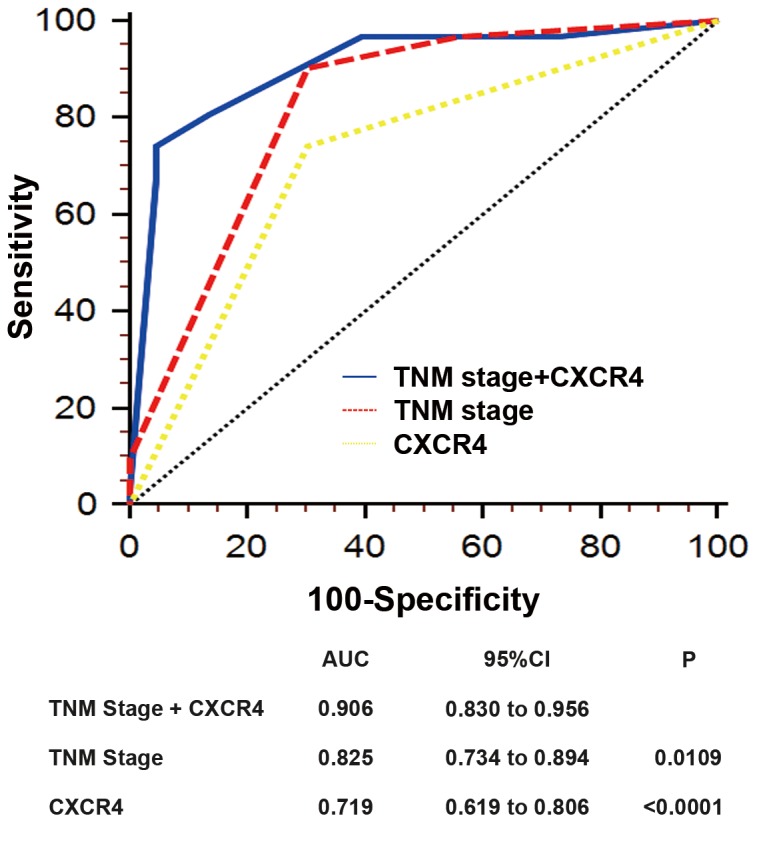
ROC analyses for the prediction of overall survival in patients with gastric cancer.ROC analyses of the sensitivity and specificity for the prediction of overall survival by the combined CXCR4 expression and TNM stage model, the TNM stage model, and the CXCR4 expression model. P values show the area under the ROC curves (AUC) of the combined CXCR4 expression and TNM stage model versus AUCs of the TNM stage model or the CXCR4 expression model. ROC, receiver operating characteristic.